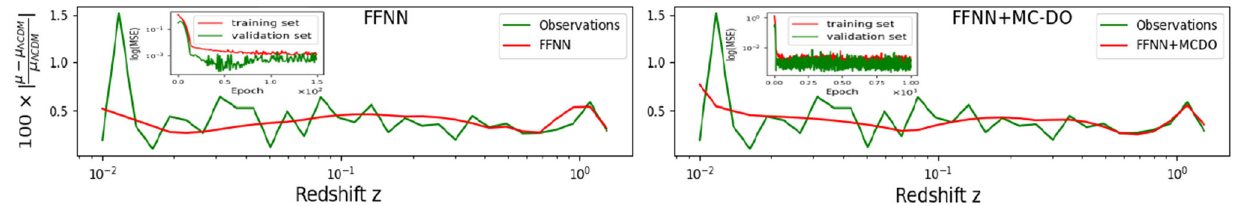
Fig. 4 Comparison between the percentage error times 100 between the (cid:3) CDM theoretical predictions for the distance modulus with the observational measurements and the neural network reconstructions. In the small panels of both figures, the behavior of the loss function, in logarithmic scale, is shown for both the validation (green curve) and